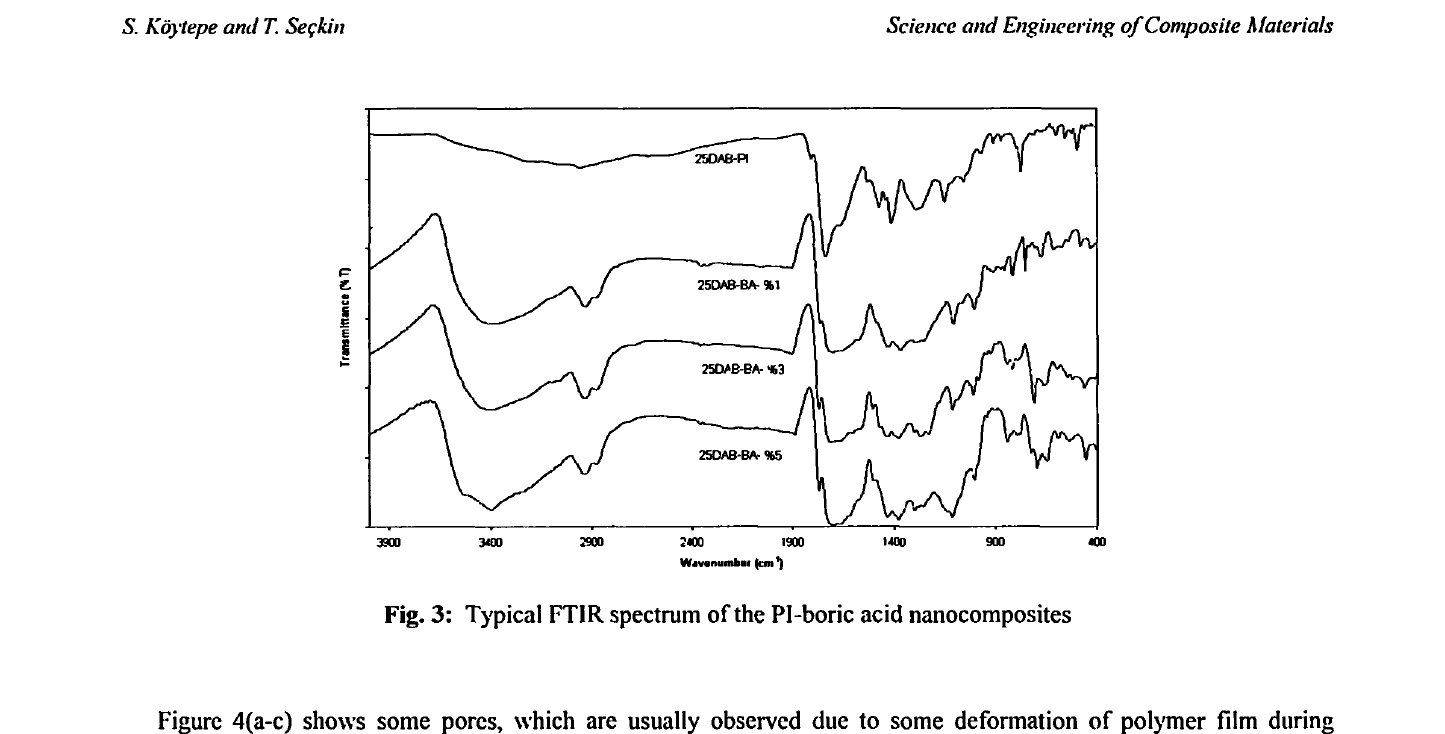
Fig. 3: Typical FTIR spectrum of the PI-boric acid